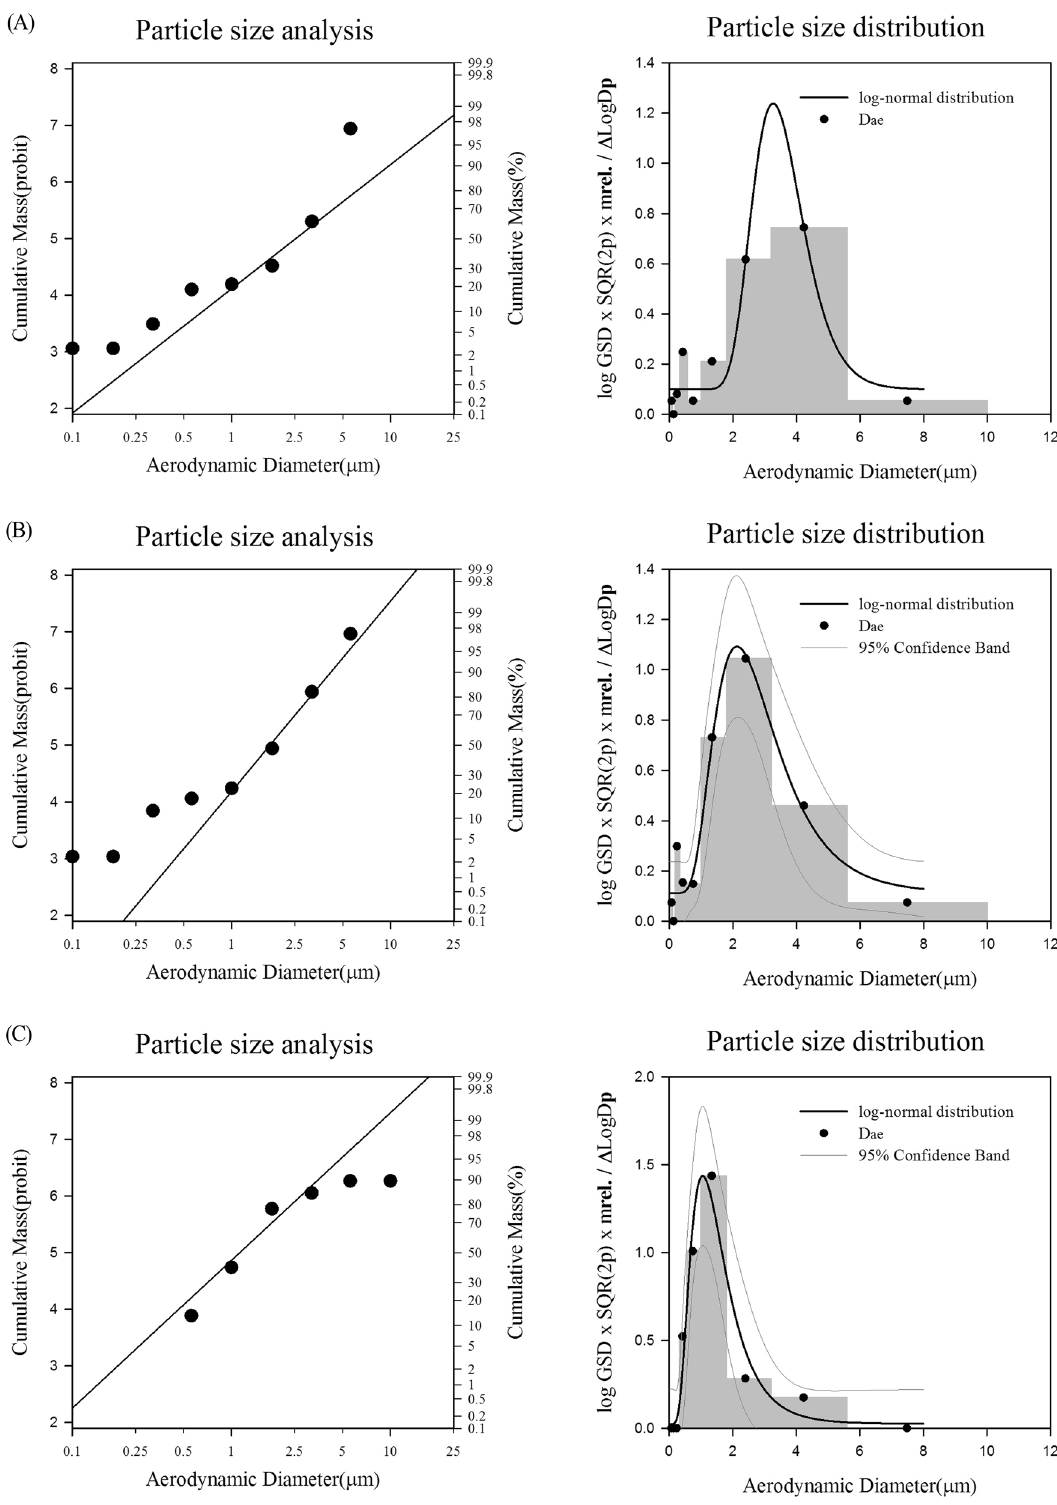
Figure 1. Particle size distributions of NaDCC in the chambers. 0.8 mg/m 3 ( A ), 4.0 mg/m 3 ( B ), 20 mg/m 3 ( C